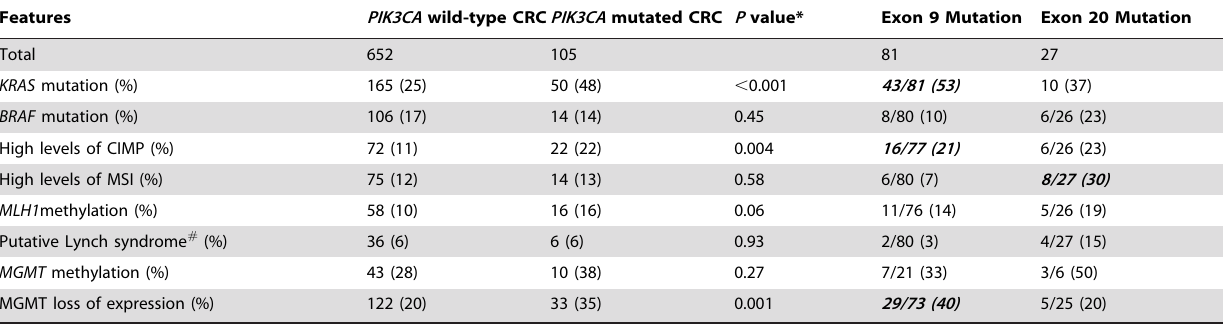
* P value comparing PIK3CA wild-type and PIK3CA -mutated tumors. There are 3 tumors with mutations in both exons 9 and 20. # Putative Lynch syndrome was defined as tumors with one of the following characteristics: loss of expression of MSH2 and MSH6, MSH6 alone, PMS2 alone, or loss of MLH1 and PMS2 expression with wild-type BRAF and/or absence of MHL1 methylation. Results for exon 9 and exon 20 mutation in italic bold indicate statistical significance ( P , 0.05) when compared with PIK3CA wild-type tumors. CRC: Colorectal carcinoma; MSI: Microsatellite instability; CIMP: CpG island methylator phenotype.